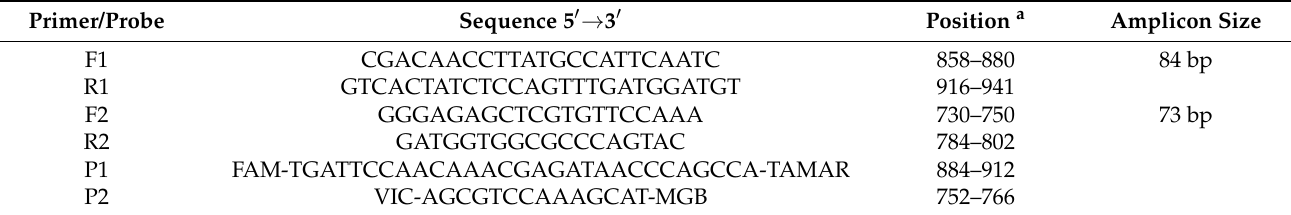
Table 1. Primers and probes for B87 and